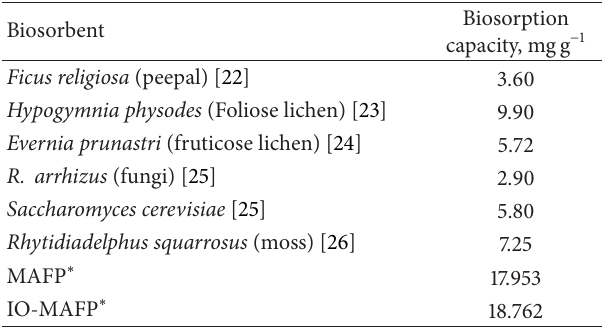
Table 4: Comparison of maximum biosorption capacities ( 𝑞 max , mg/g) of Co(II) with various biosorbent at 25 ∘